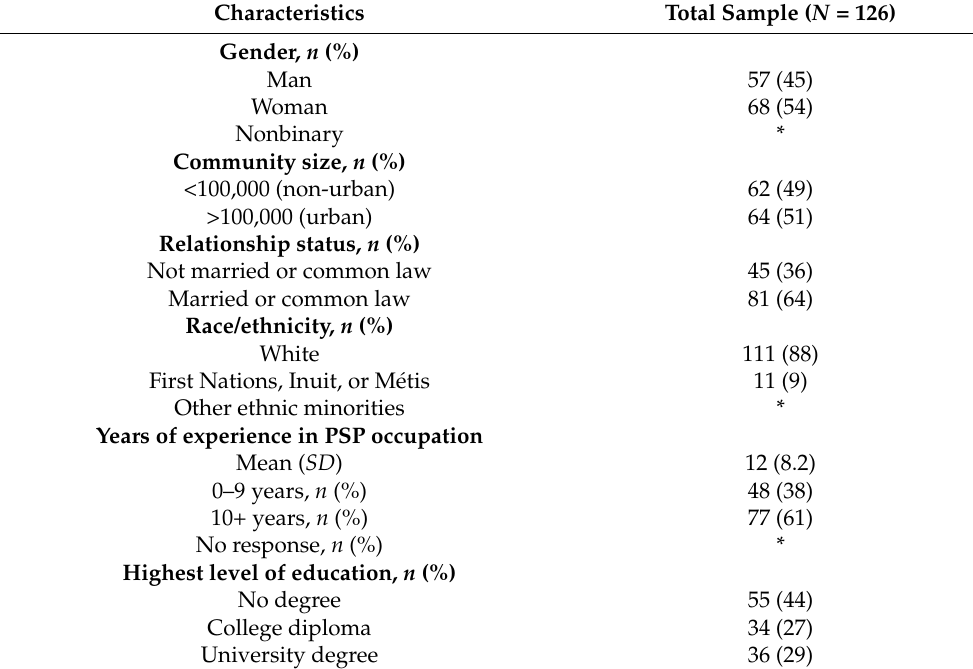
Table 1. Client Table 1. Client characteristics.